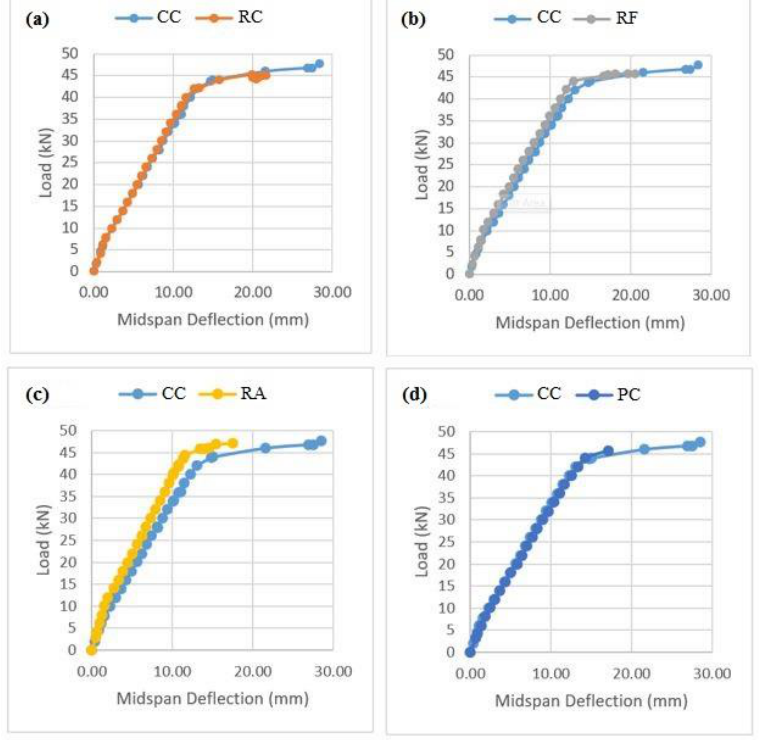
Figure 4. Comparison of mid-span deflection values of all beams containing ceramic wastes with